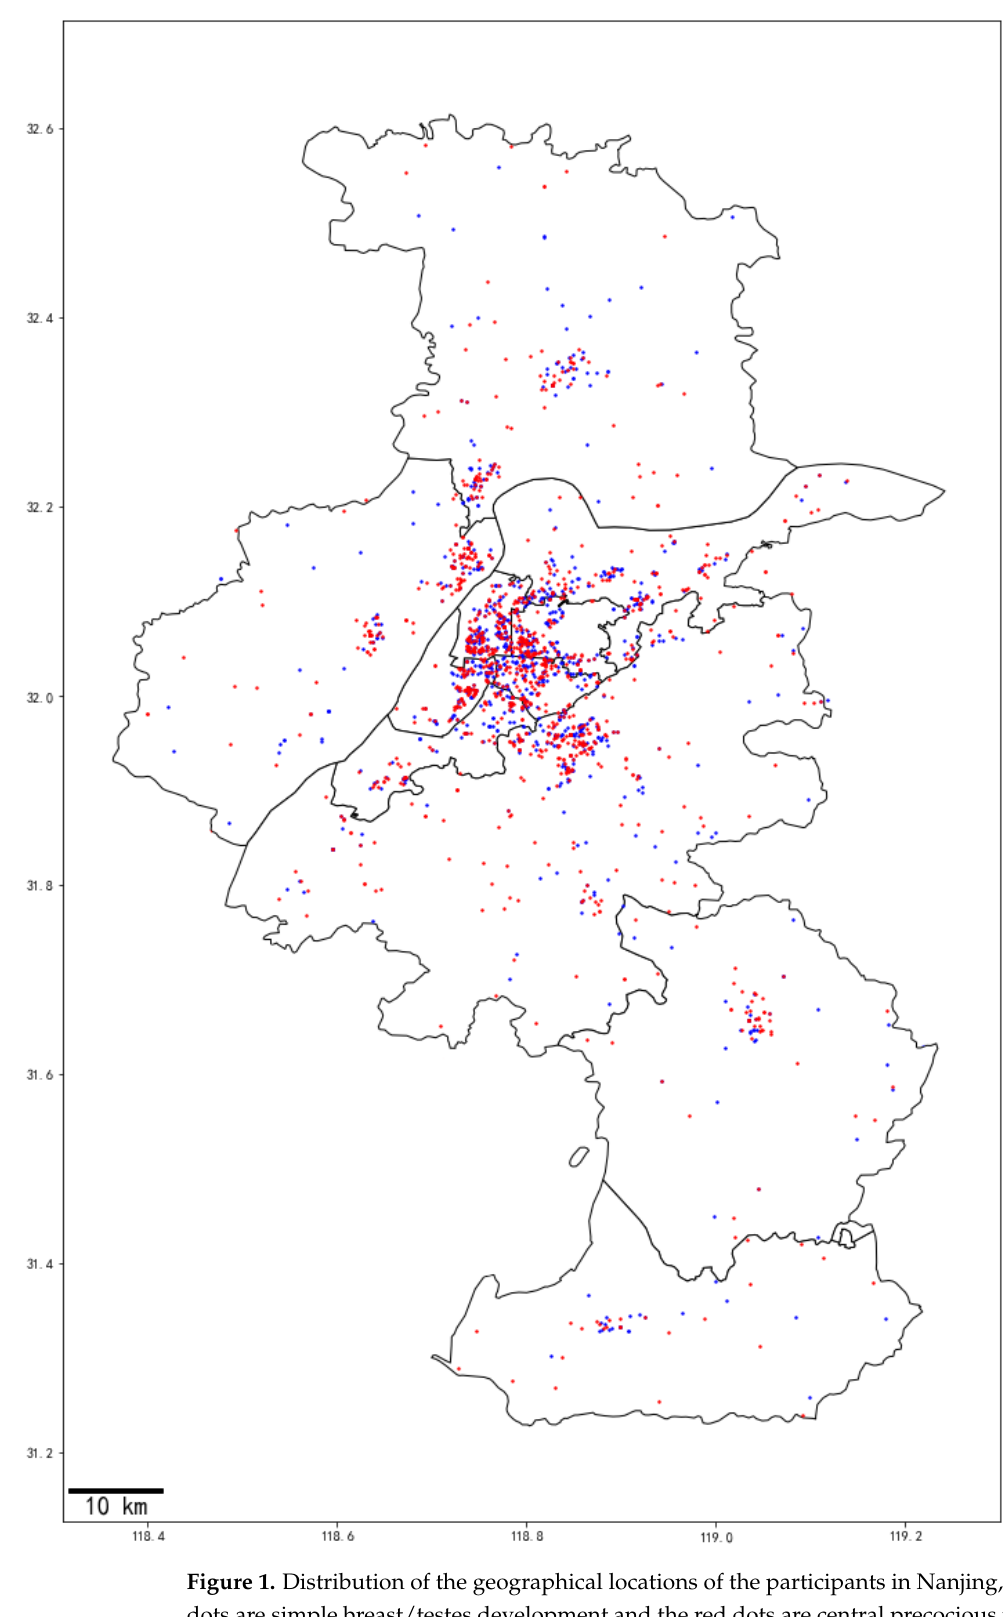
Figure 1. Distribution of the geographical locations of the participants in Nanjing, China. The blue dots are simple breast/testes development and the red dots are central precocious puberty.